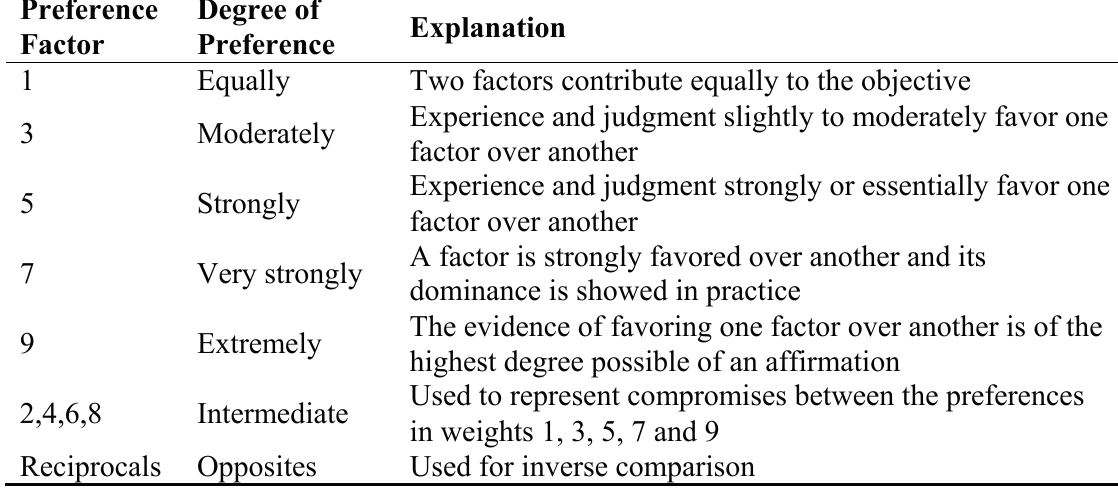
Table 1. Scale of preference between two parameters in Analytic Hierarchy Process (AHP) (adapted from [21]).